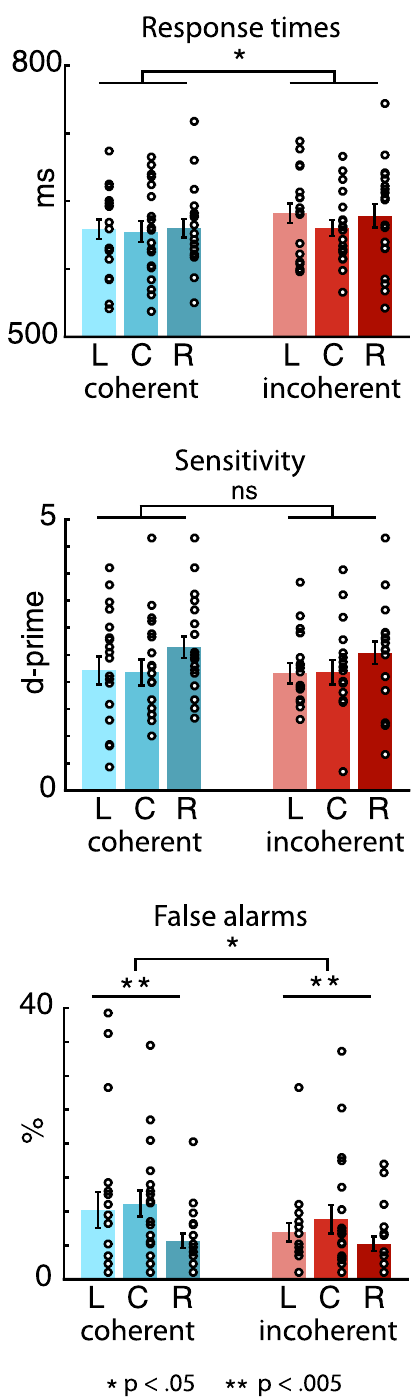
Figure 4. Behavioural results. Mean response times (top barplot), d-prime values (middle barplot), and false- alarm rates (bottom barplot) to targets presented from the left (L), center (C) and right (R). Blue hues indicate coherent conditions (attention and gaze towards the same location), red hues indicate incoherent conditions (attention and gaze towards different locations). The dots represent the individual participants’